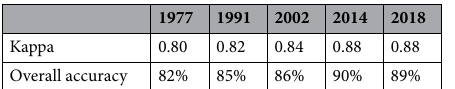
Table 1. Overall classification accuracy and kappa